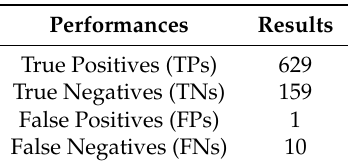
Figure 7. Confusion matrix resulting from the fall detection system. Table 3. Two-output system performances. Falls and Warnings are grouped in the same class and ADLs constitute a class